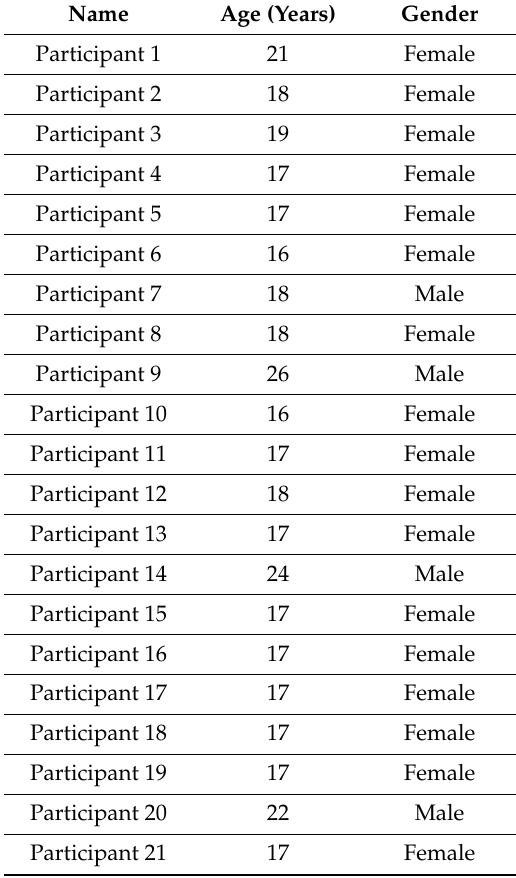
Table 2. Details of the